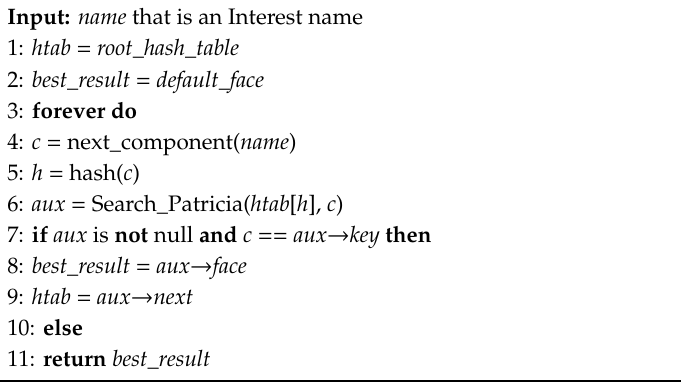
Algorithm 1: Algorithm for Name Lookup in FIB